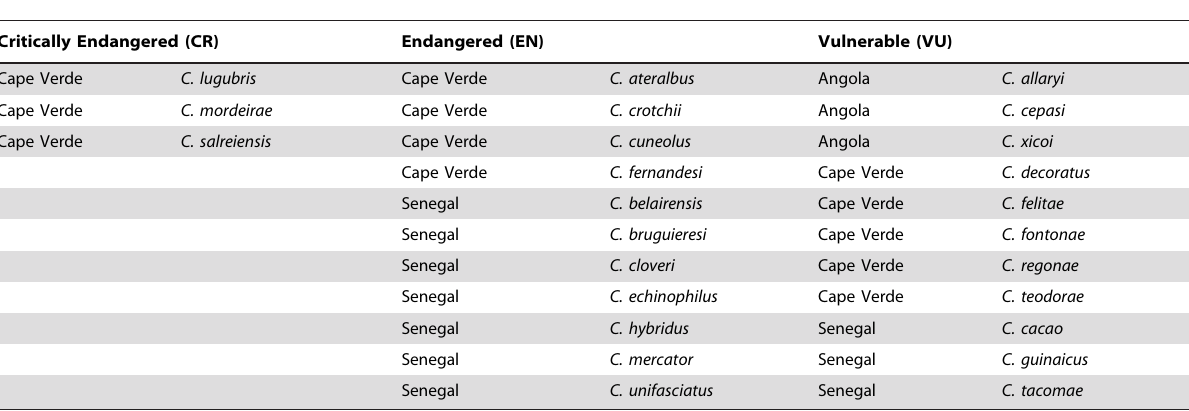
Table 1. Threatened Conus of the Eastern Atlantic